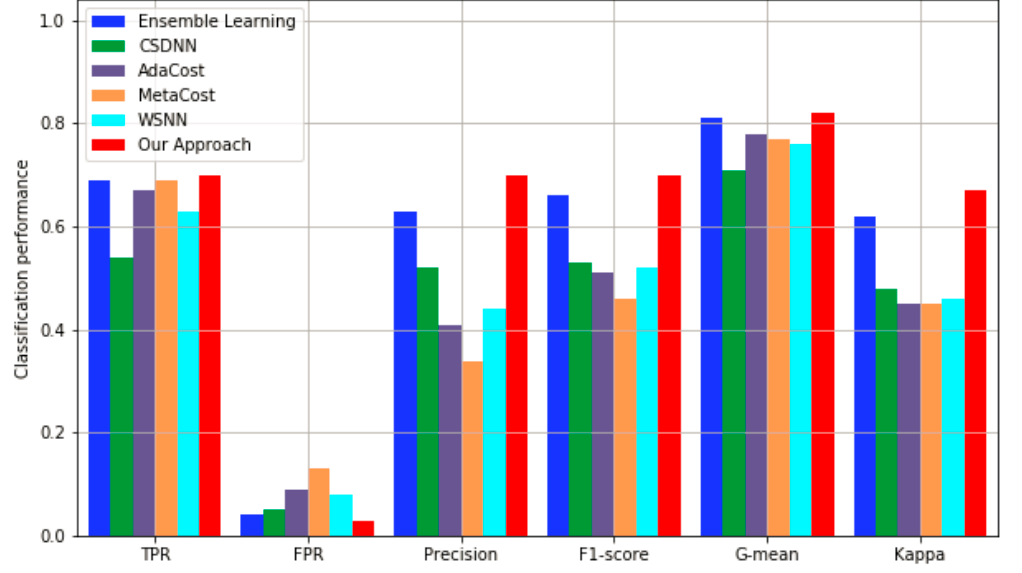
Figure 5. The performance of our proposed method is compared with class imbalance methods.